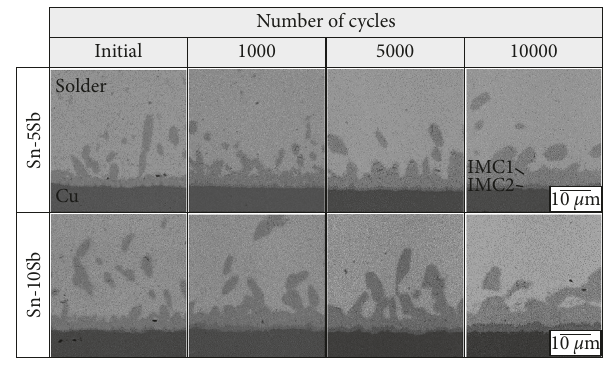
Figure 10: Back-scattered electron images of cross sections of IMC layers formed in interfaces of Sn-Sb/Cu joints after heat aging test at 100 ° C.